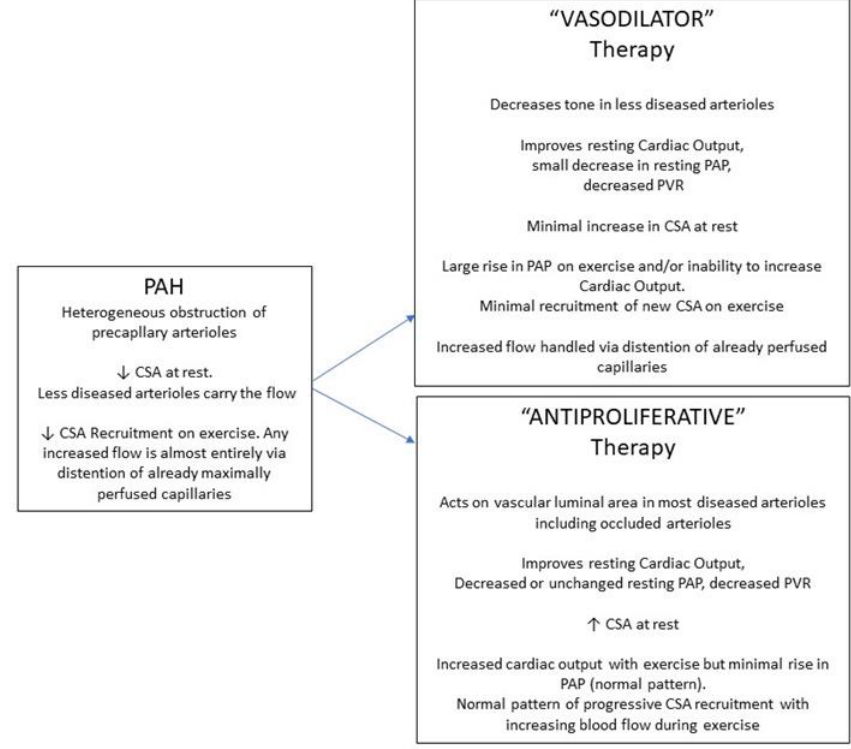
Figure 4. Schematic representation of the effects of pulmonary arterial hypertension (PAH) on pul- monary capillary surface area (CSA). Shown are the potential effect that vasodilator-type therapies (VASODILATOR), and therapies that would affect cellular proliferative obstruction (ANTIPROLIFER- ATIVE), would have on hemodynamics (PAP, pulmonary artery pressure; PVR, pulmonary vascular resistance) and CSA, at rest and upon exercise.